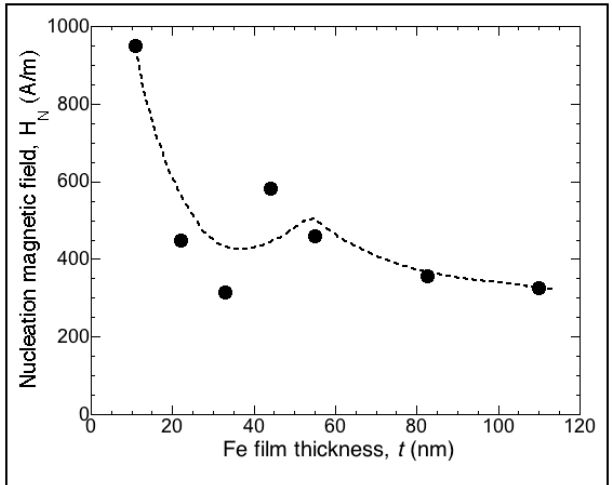
Figure 4. Dependence of nucleation magnetic field H N on film thickness t . Overall behavior indicated that H N decreased with thickness, although a slight increase was observed at thicknesses between ≈ 35 and 45 nm. Dashed line is a visual guide.